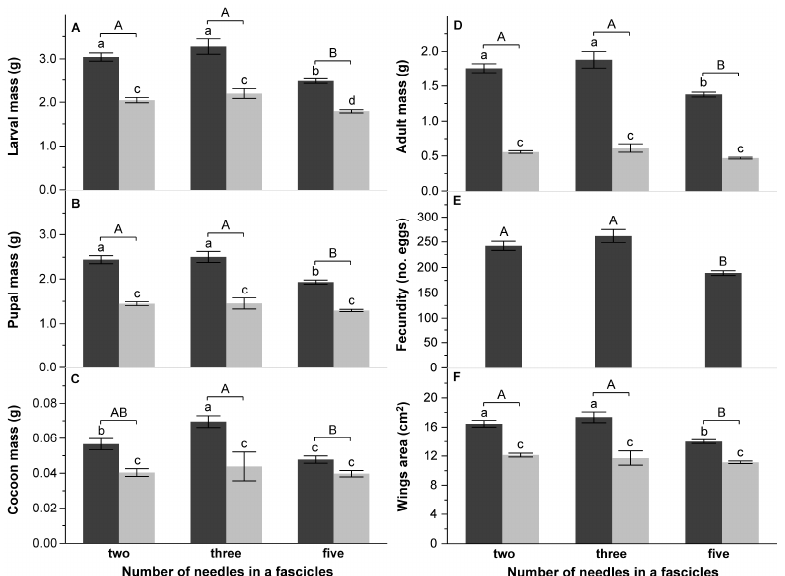
Figure 4. Mean values (±SE) of maximal larval mass ( A ), pupal mass ( B ), cocoon mass ( C ), adult mass ( D ), fecundity ( E ), and wing area ( F ) achieved by the pine-tree lappet ( Dendrolimus pini L.) larvae, which were fed with needles of pine species with different numbers of needles in fascicles (two, three, and five) classified by sex: females (dark) and males (light). Lowercase letters above the bars indicate result of Tukey’s post hoc test ( α = 0.05) for interaction number of needles × month, and uppercase letters indicate result for number of needles in a fascicle treatment (see also Table 1). Levels not connected by same letter are significantly different.